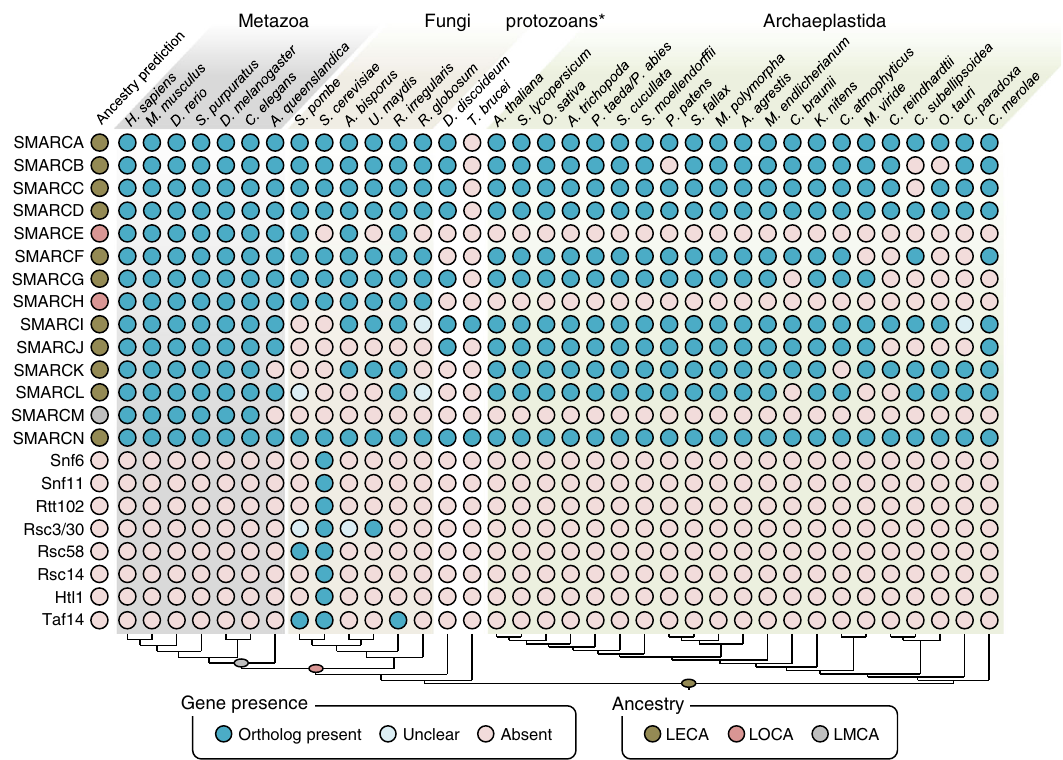
Fig. 1 Occurrence of SWI/SNF subunits in different eukaryotes. Blue- fi lled circles indicate at least a positive hit for the search of a given component (rows) in speci fi c species (columns). Light blue circles indicate the presence of a plausible or distant ortholog hit. Names for each subunit derive from consensus names (see Table 1). The presence of a given homolog was determined as described in Materials and Methods. Ancestral prediction indicates the most likely ancestor that contained a given subunit based on the presence in distinct lineages and species. *protozoan species are entitled together even though they do not form a natural group. The lower cladogram indicates phylogenetic relationships between species. LECA Last Eukaryotic Common Ancestor, LOCA Last Opisthokontan Common Ancestor, LMCA Last Metazoan Common Ancestor, H. sapiens Homo sapiens , M. musculus Mus musculus , D. rerio Danio ( Brachydanio ) rerio , S. purpuratus Strongylocentrotus purpuratus , D. melanogaster Drosophila melanogaster , C. elegans Caenorhabditis elegans , A. queenslandica Amphimedon queenslandica , S. pombe Schizosaccharomyces pombe , S. cerevisiae Saccharomyces cerevisiae , A. bisporus Agaricus bisporus , U. maydis Ustilago maydis , R. irregularis Rhizophagus irregularis , R. globosum Rhizoclosmatium globosum , D. discoideum Dictyostelium discoideum , T. brucei